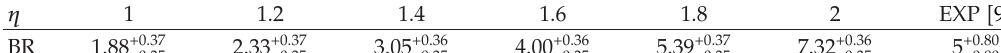
Table 1: The branching ratio of B (cid:2) → J/ψρ (cid:2) decay with η (cid:6) 1 ∼ 2 and experimental data (cid:3) in units of 10 − 5 (cid:4) .